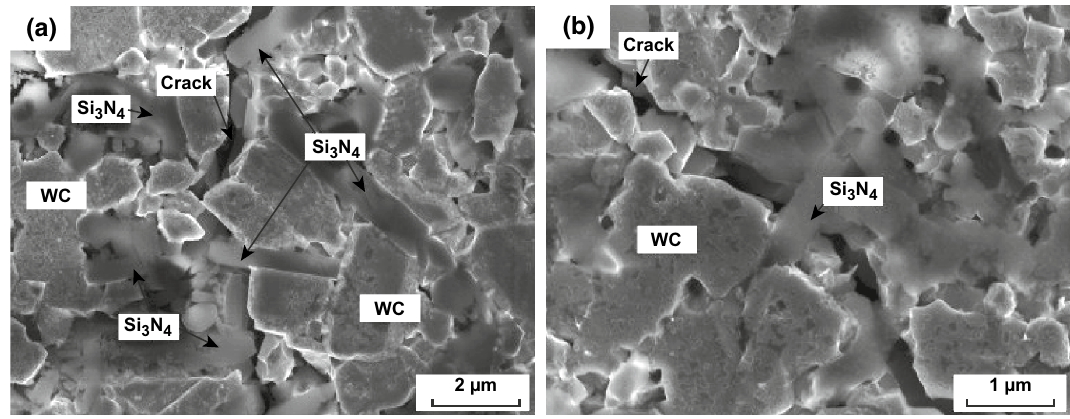
Fig. 12 SEM images of indentation cracks observed in the sintered WC–Si 3 N 4 composites: a Si 3 N 4 whiskers pullout, b crack‑bridging by Si 3 N 4 whiskers [153]. Figure panels reproduced from Ref. [153] with permission from Elsevier copyright